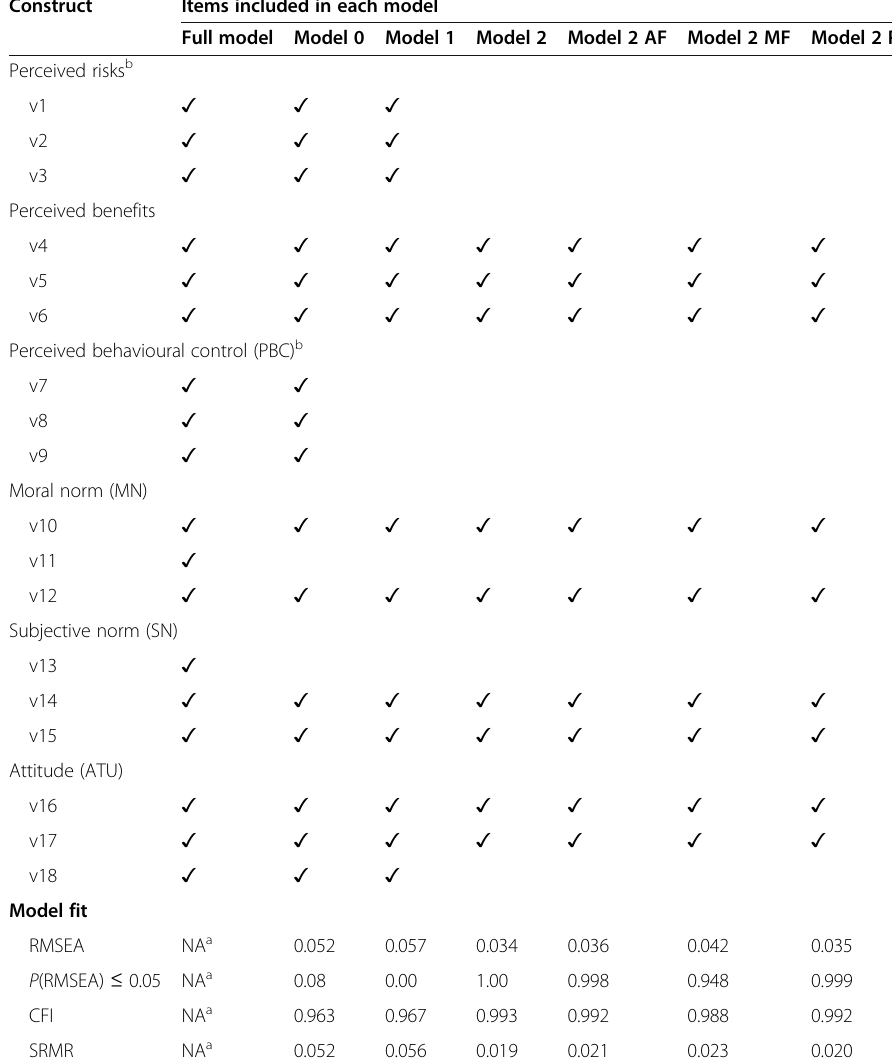
Table 6 Testing the factorial validity of the confirmatory factor analysis models Construct Items included in each